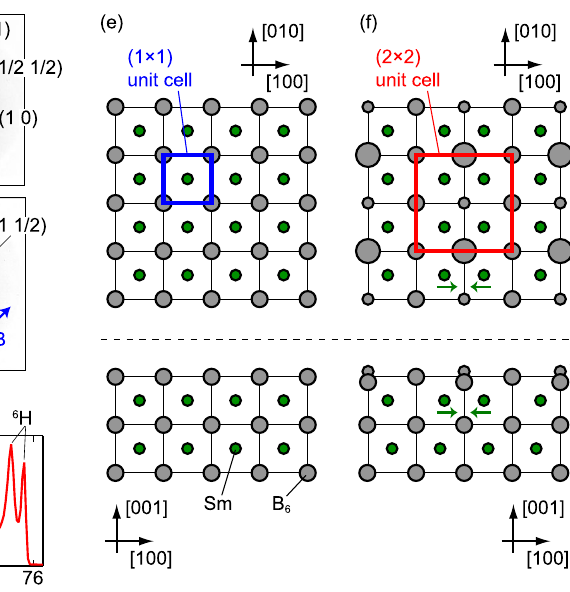
integrated photoelectron spectra taken at 13K. 6 F and 6 H are the Sm 2+ 4 f 5 fi nal states after photoexcitation. e A surface atomic structure of SmB 6 (001) without any surface superstructure. f The same as ( e ) but with hypothetical p (2×2) sur- face reconstruction. Arrows guide the displacements of Sm and B6 near the